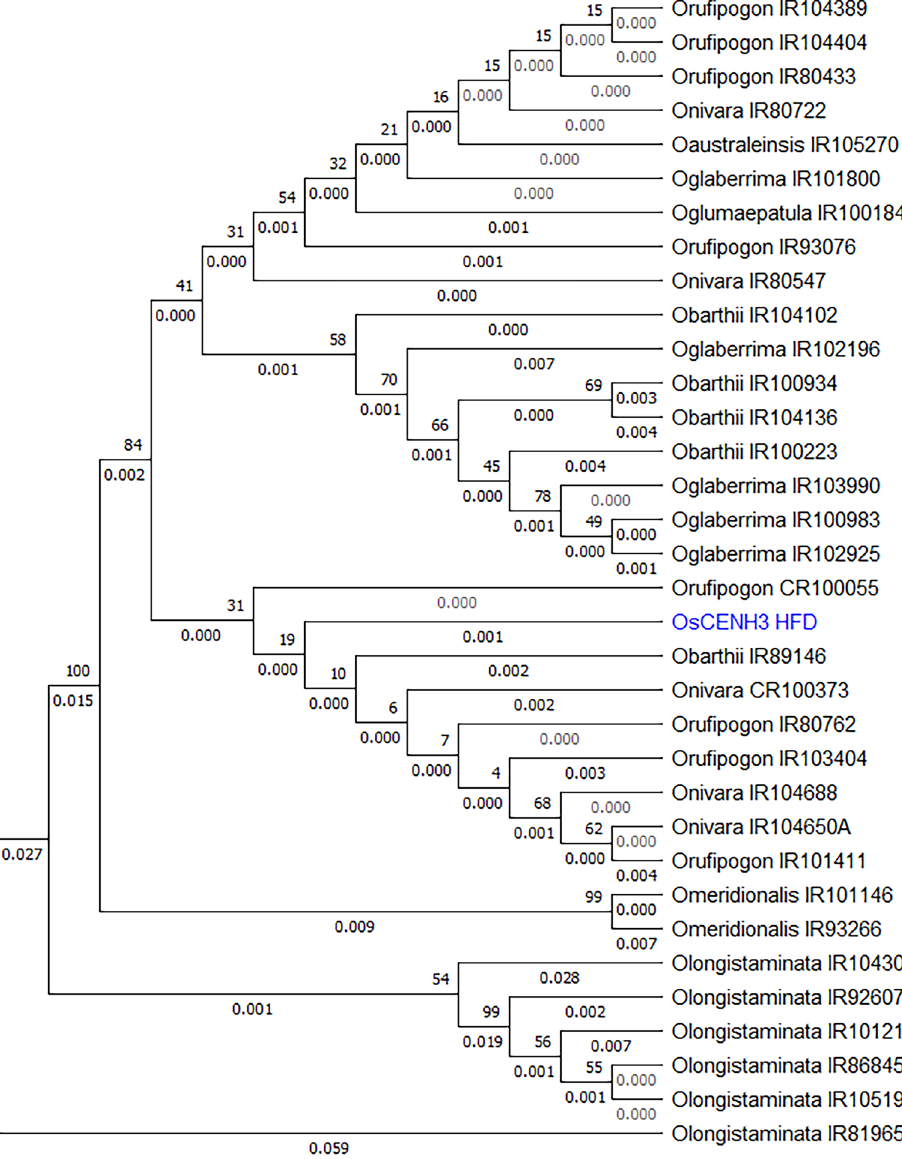
Figure 5. Phylogenetic analysis limited to HFD domain of sampled CENH3 alleles: Dendrogram generated using only CENH3 HFD region sequences of 33 accessions in MEGA version X at bootstrap 1000 using the neighbour-joining method. Accessions as listed in Table